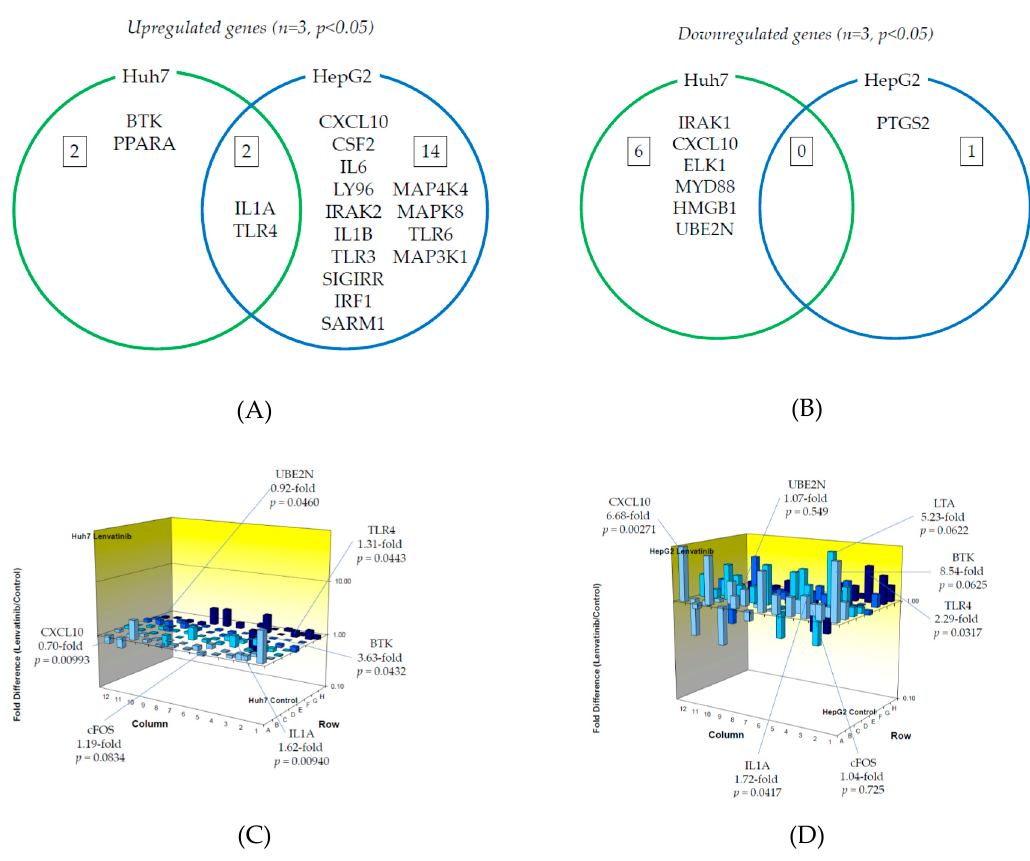
Figure 4. Effects of lenvatinib treatment on Toll-like receptor (TLR)-related gene expression in human hepatoma Huh7 and HepG2 cells: ( A ) Upregulated genes ( p < 0.05); ( B ) Downregulated genes ( p < 0.05). ( C ) Changes of TLR-related gene expression in Huh7 cells treated with or without lenvatinib; ( D ) Changes of TLR-related gene expression in HepG2 cells treated with or without lenvatinib. Cells were treated with or without 2 µ M lenvatinib for 24 h and cellular RNA was extracted. Eighty-four TLR-related genes were evaluated by real-time PCR-based array ( n = 3). p -values, compared to those of untreated cells.